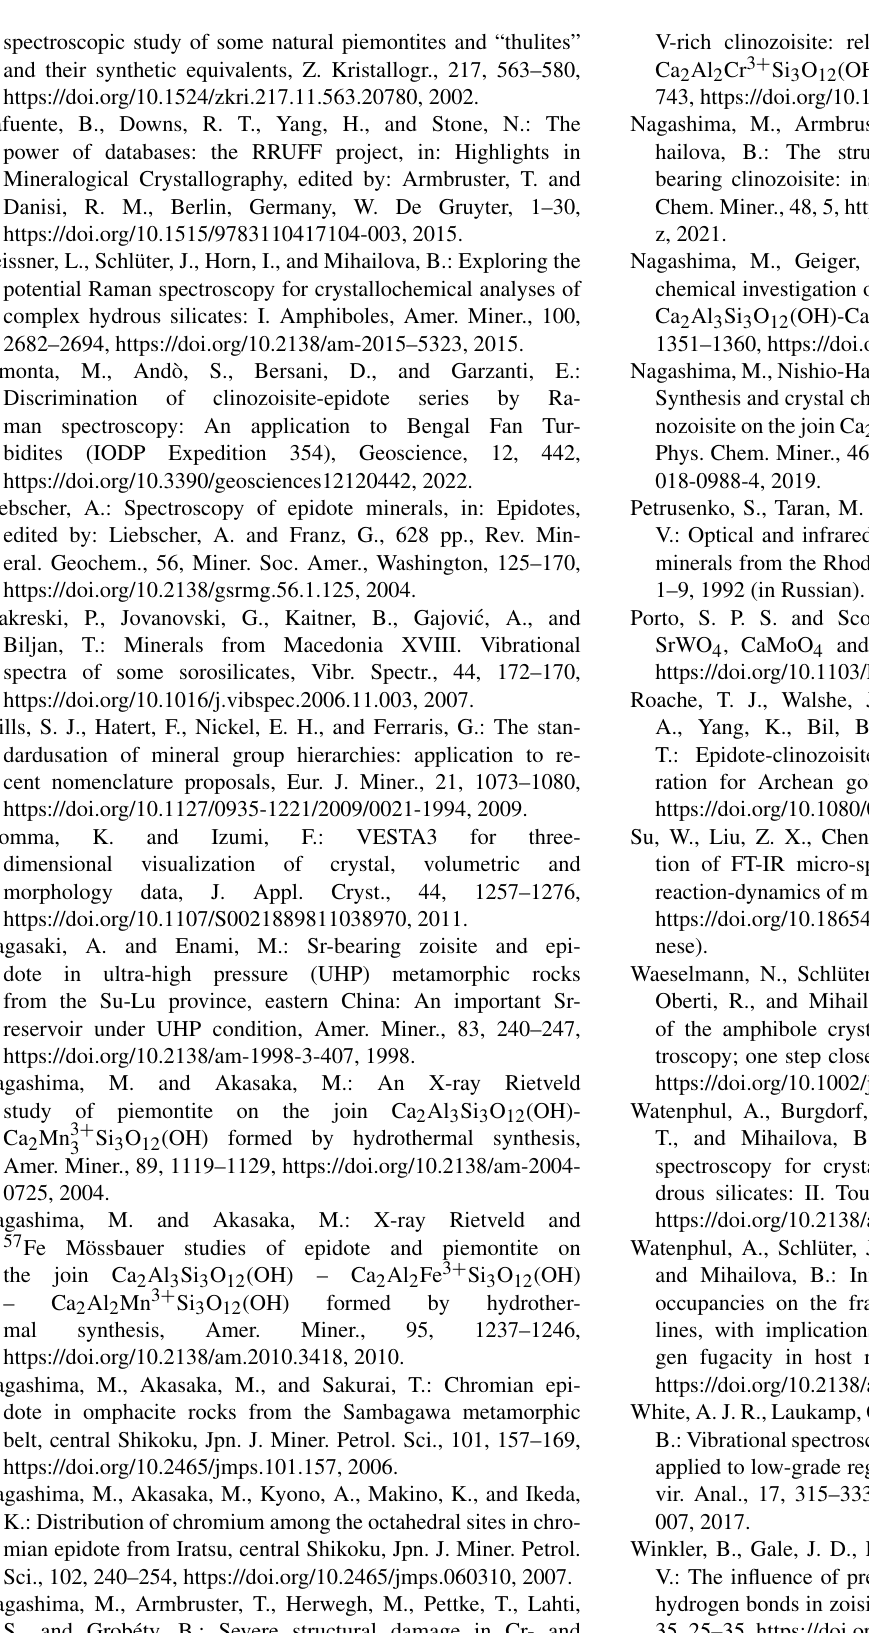
B.: Vibrational spectroscopy of epidote, pumpellyite and